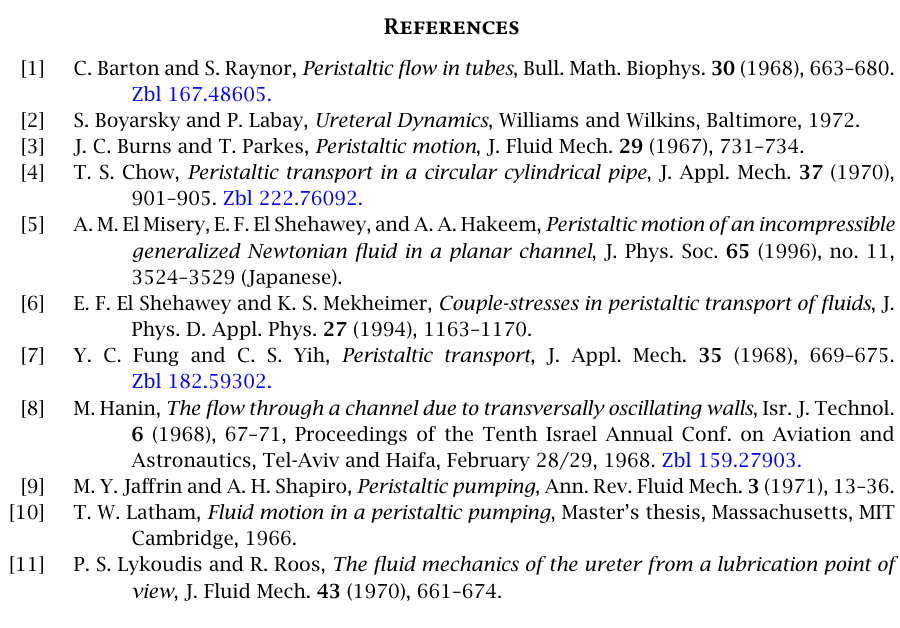
Figure 5.6 The effect of Poiseuille parameter k on the mean-velocity distri- bution and reversal flow at Re = 5 . 0, (cid:23) = 0 . 15, and (∂P/∂z) = 10 .